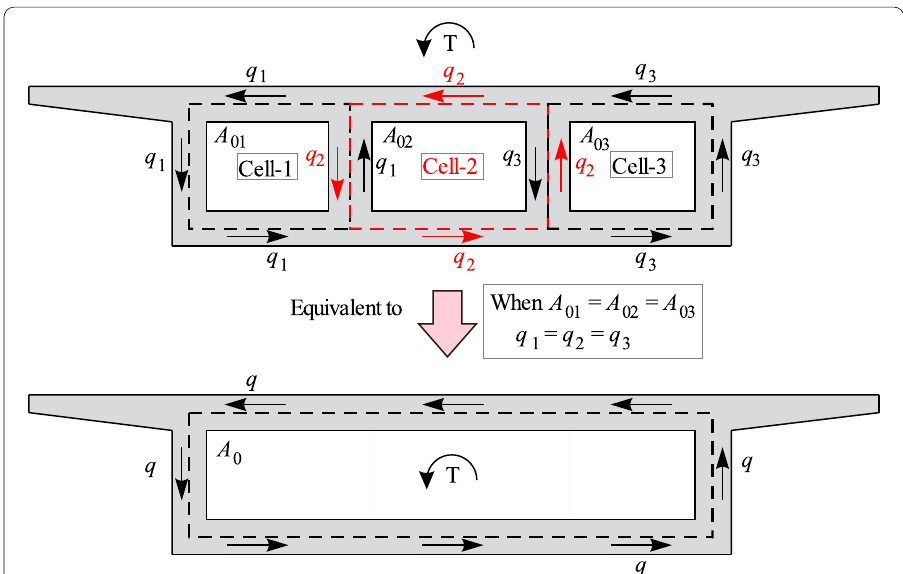
Fig. 2 The shear flows in a single-box triple-cell